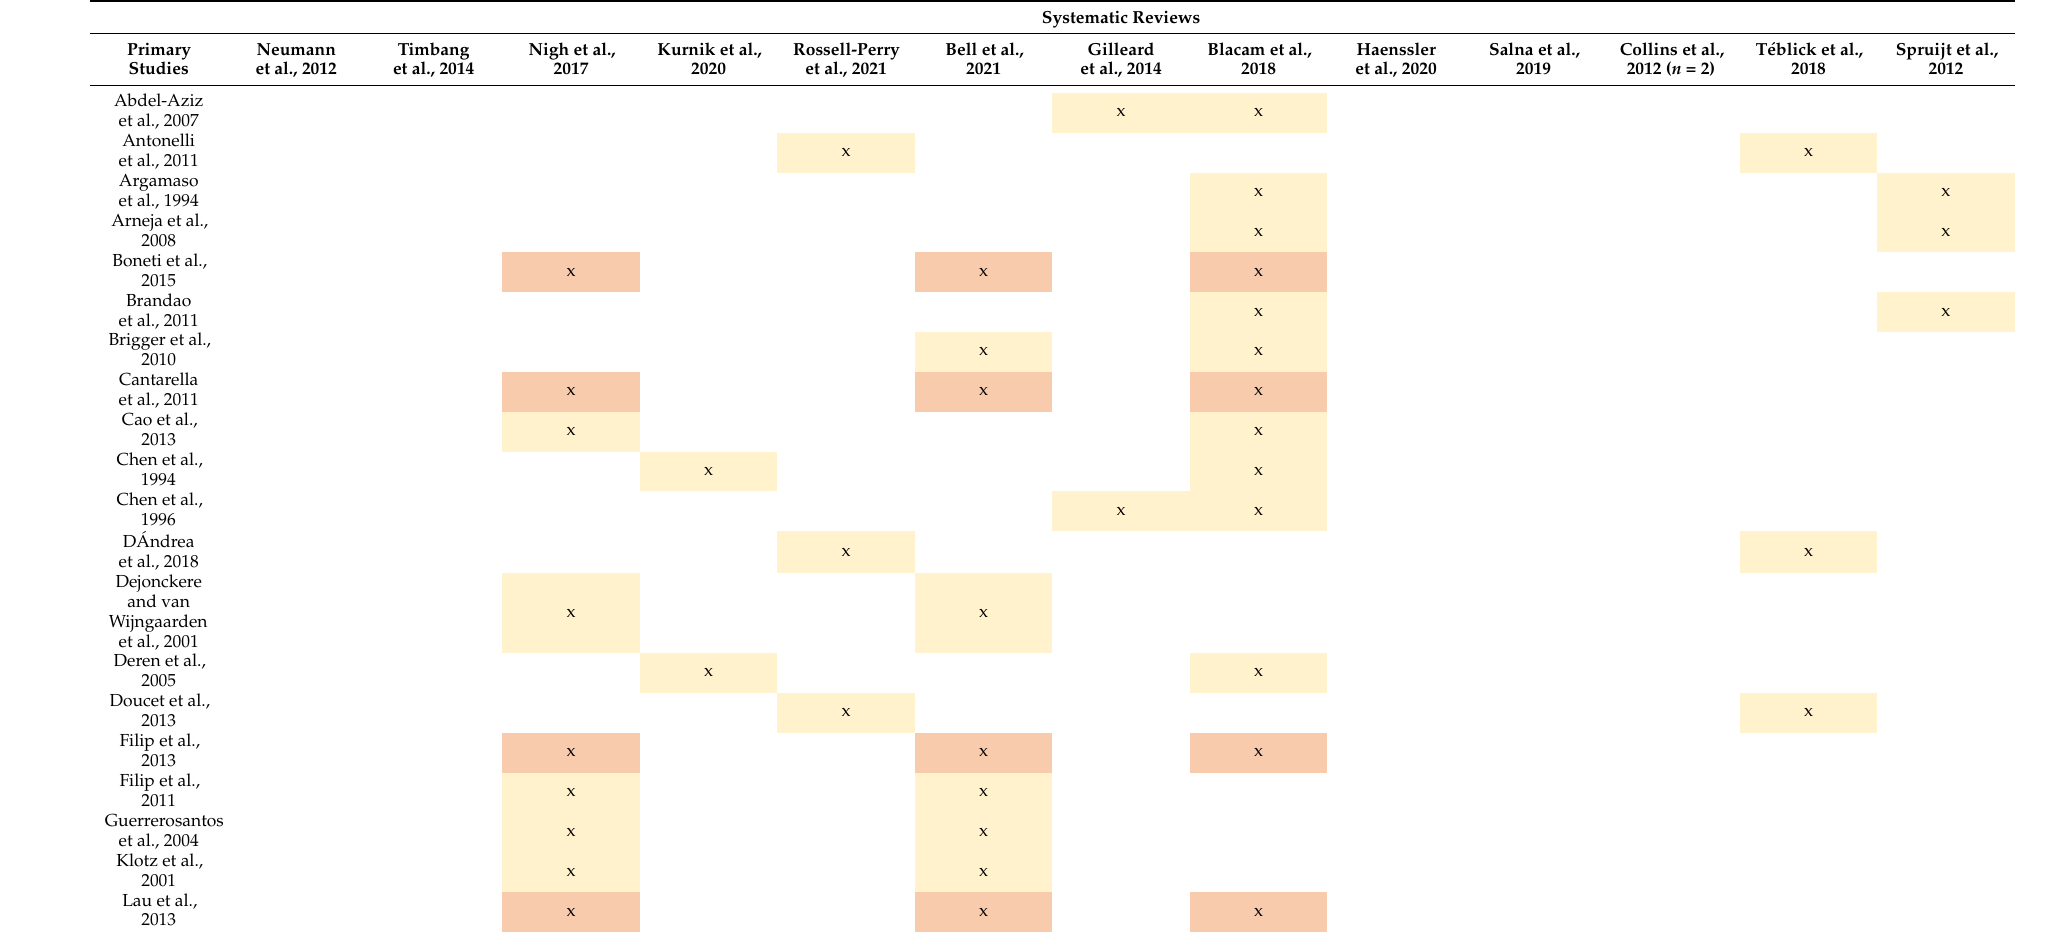
Table 6. Citation matrix for duplicate primary